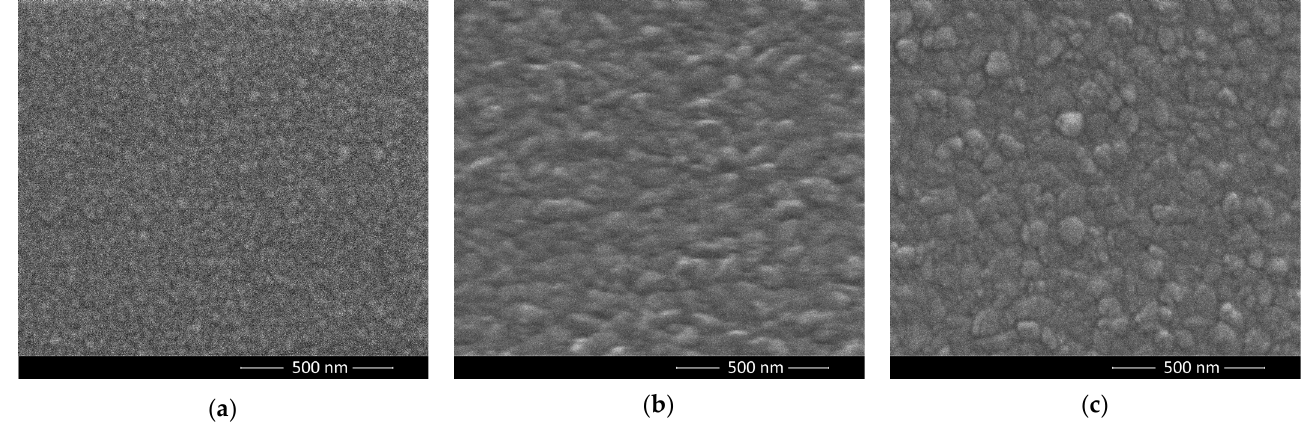
Figure 6. Surface morphology of the deposited layer when using the DC power supply and for the deposition times of ( a ) 5 min, ( b ) 10 min, and ( c ) 15 min. Similarly, the morphology analysis results for the case of the HiPIMS power supply are represented in Figure 7, for the same time durations of the deposition process (5, 10, and 15 min, respectively).